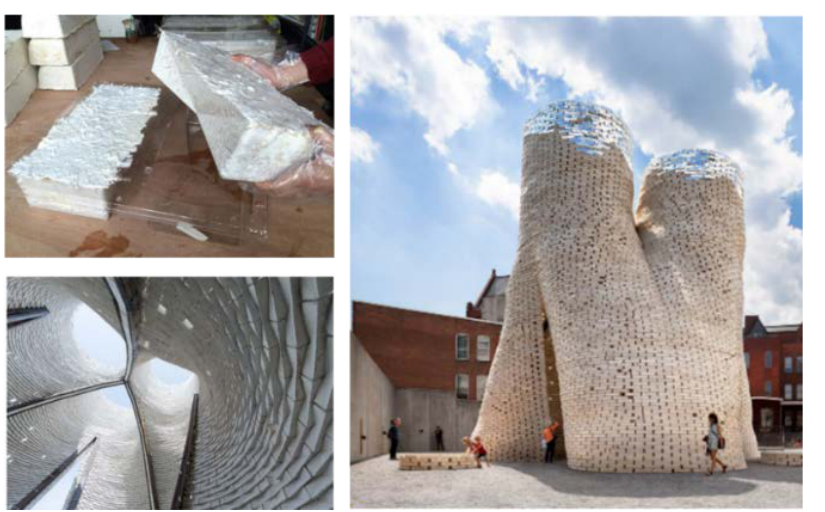
Figure 9 Hi-Fi Tower-2014 (Url-13).